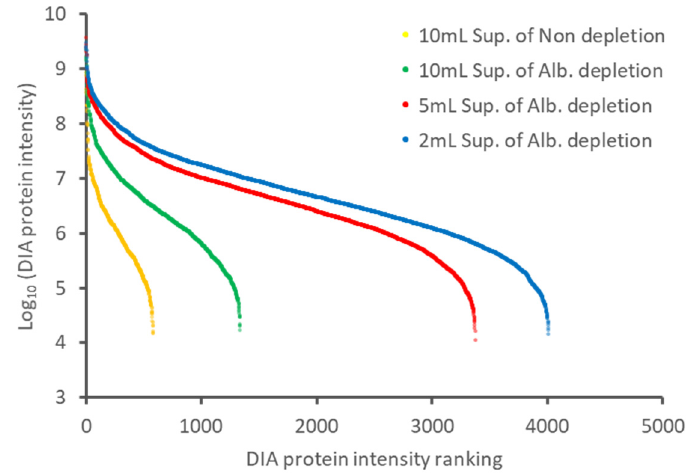
Figure 4. The dynamic range of protein concentration in the supernatant samples treated with different approaches. The proteins of an average DIA protein intensity in each treated sample were plotted. Yellow dots represent non-depletion of the supernatant cultured in 10 mL of the medium. Green, red, and blue dots represent albumin depletion of the supernatant cultured in 10, 5, and 2 mL of the medium, respectively. Abbreviations: ALB, serum albumin; Sup, supernatant.